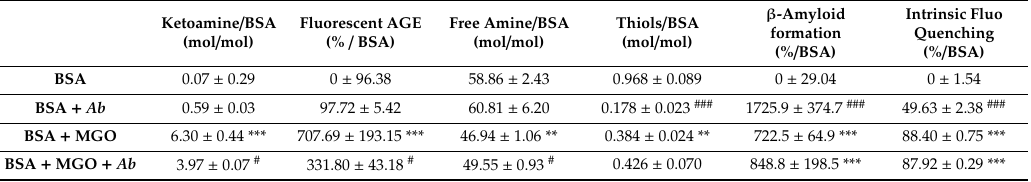
Table 4. Impact of Antirhea borbonica on methylglyoxal (MGO)-induced non-glycated albumin (BSA)